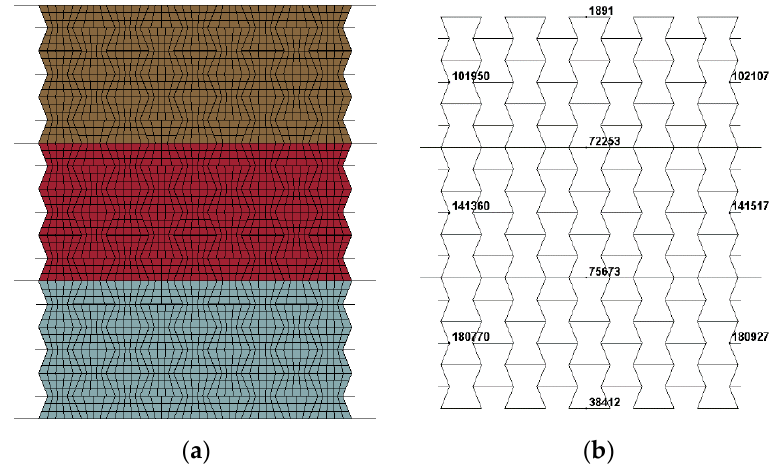
Figure 29. The representative points for effective Poisson’s ratio calculation: ( a ) numerical model; ( b ) representative points.